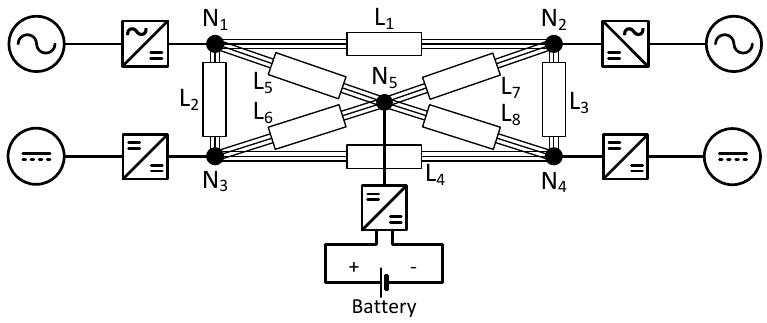
Figure 1. Bipolar DC distribution system containing storage, sources and loads.